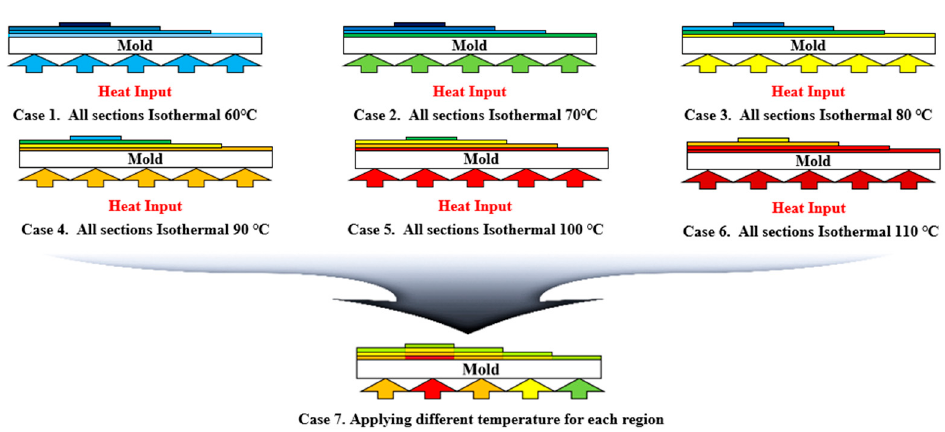
Figure 1. Method to improve temperature unevenness due to shape and thickness of spar-cap using reference models.